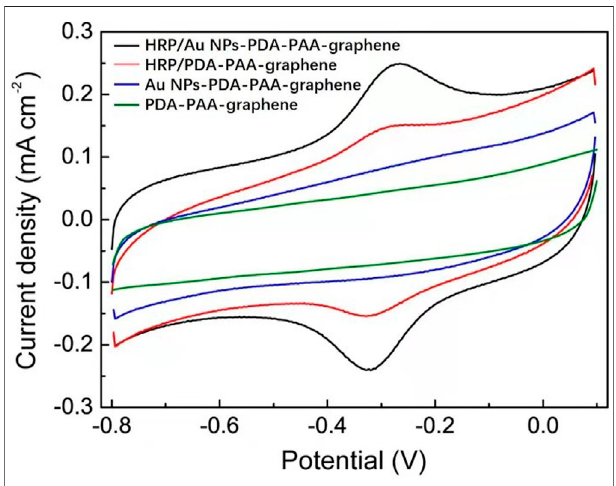
FIGURE4| CVcurvesofHRP/AuNPs-PDA-PAA-graphene,HRP/PDA- PAA-graphene, Au NPs-PDA-PAA-graphene and PDA-PAA-graphene in